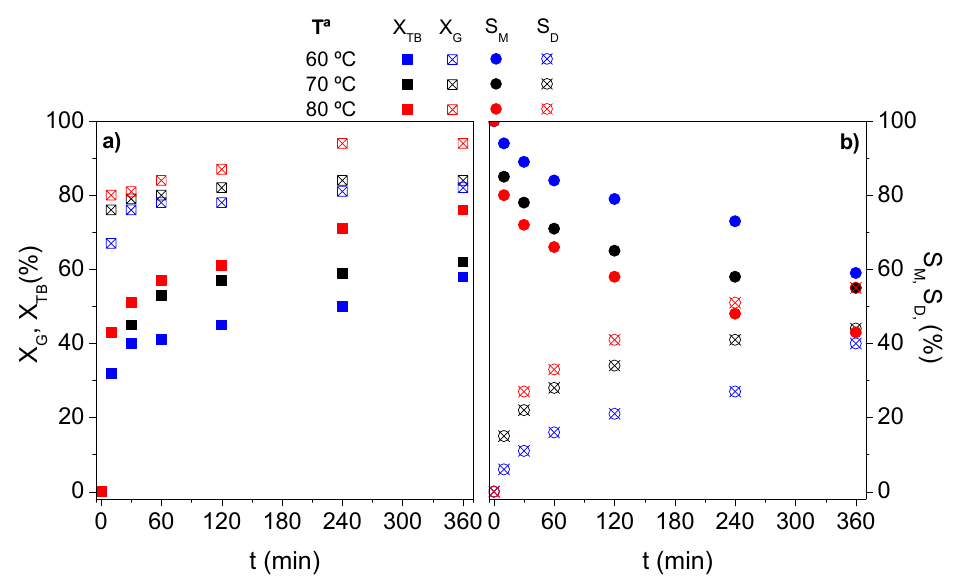
Figure 6. Influence of reaction temperature on G and TB conversion ( a ) and M and D selectivity ( b )